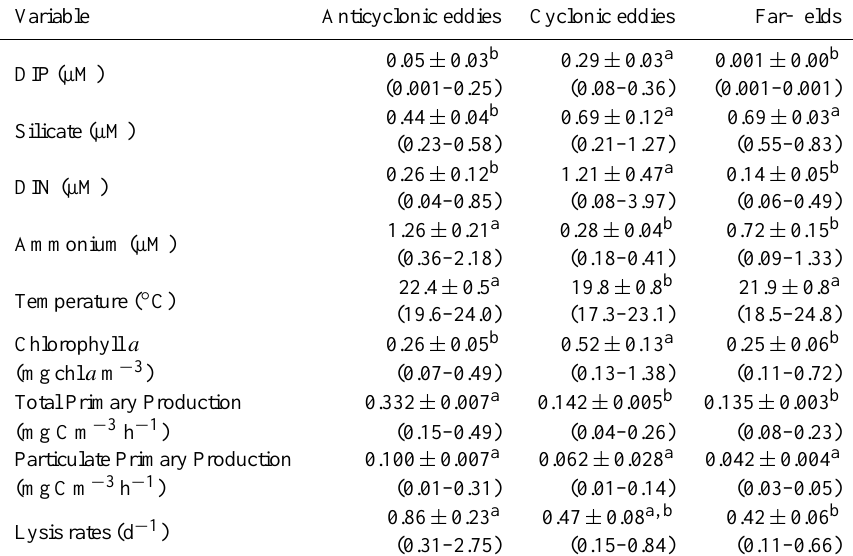
Table 2. Average ± SE and range of variability of nutrients concentration, temperature, chlorophyll a , primary production (total and partic- ulate) and lysis rates observed in the water column of the cyclonic and anticyclonic eddies and far-field stations studied. Average values for systems connected by different letters (a, b) are significantly different ( p <